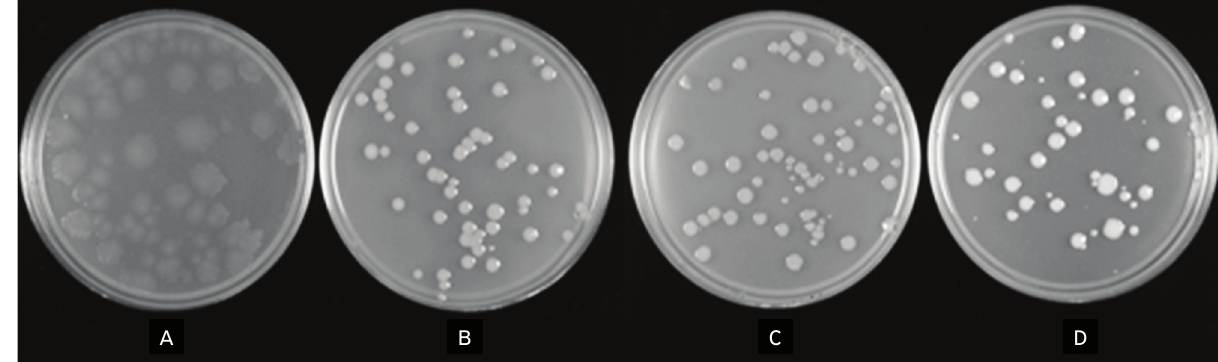
45°C.A B C DA B C Figure 4. Alicyclobacillus acidoterrestris colonies in: (A) K agar, (B) ALI, (C) YSG and (D) BAT agar after 72 hours at